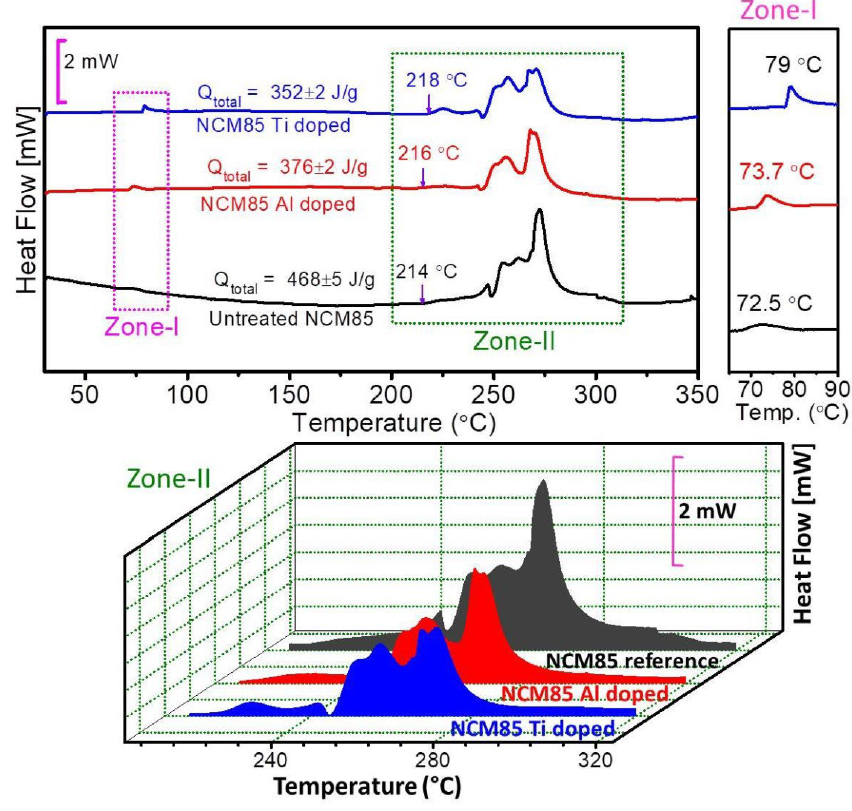
Figure 4. DSC measurements of NCM85 reference, Al-doped and Ti-doped cathode materials with electrolyte [49].